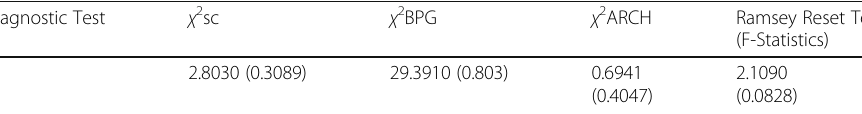
Table 7 Diagnostic Tests for long-run Diagnostic Test